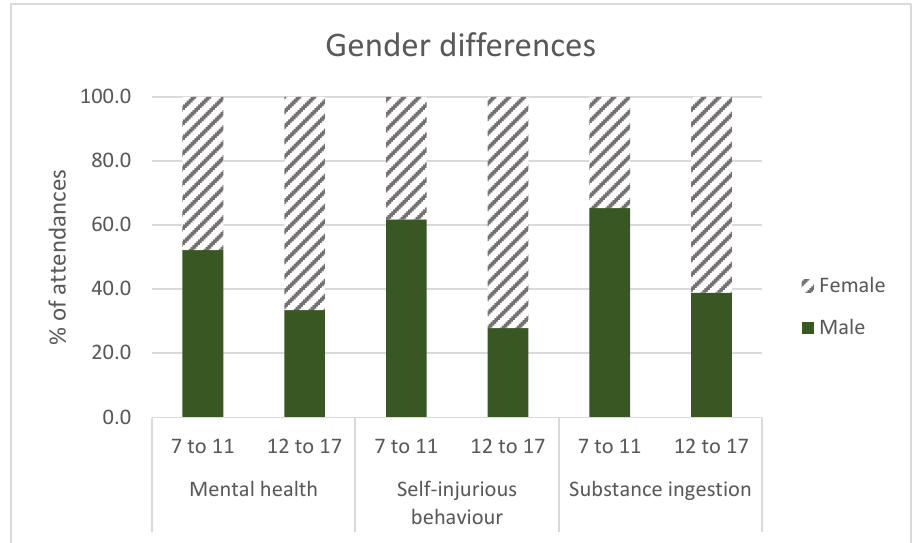
Figure 3. Ambulance attendances in the gender trend between two age groups for mental health, self-injurious behaviour and substance ingestion. Males are significantly over-represented for all three outcomes in the 7–11 age group compared to the 12–17 age group, where females predominate.